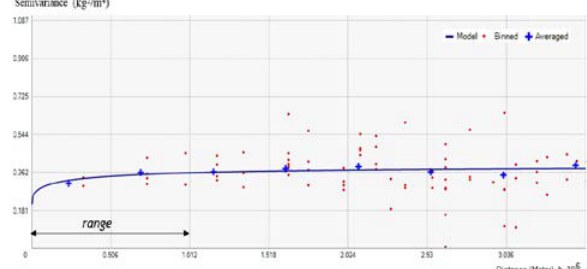
Figure 5. Semi-variogram model of Canadian forest SOC distribution using Ordinary Kriging based on 1,317 samples collected from the Canada Forest Service